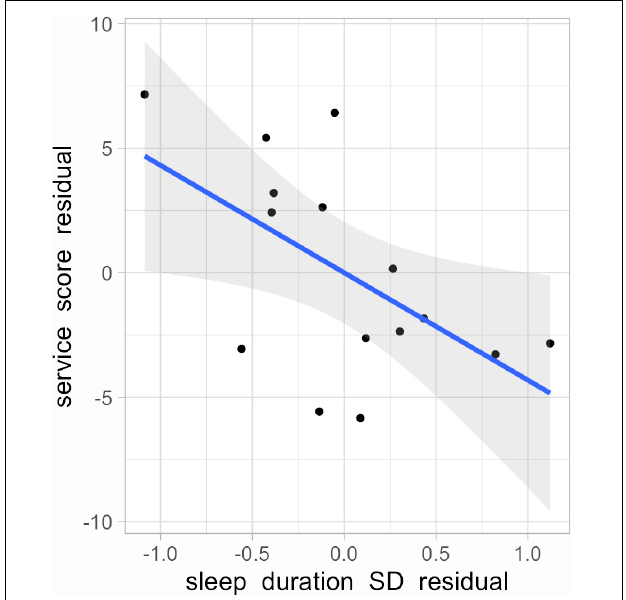
FIGURE 3 | Relationship of sleep duration SD residual and service score residual ( r = − 0.56, p = 0.046, 1- β = 0.63).